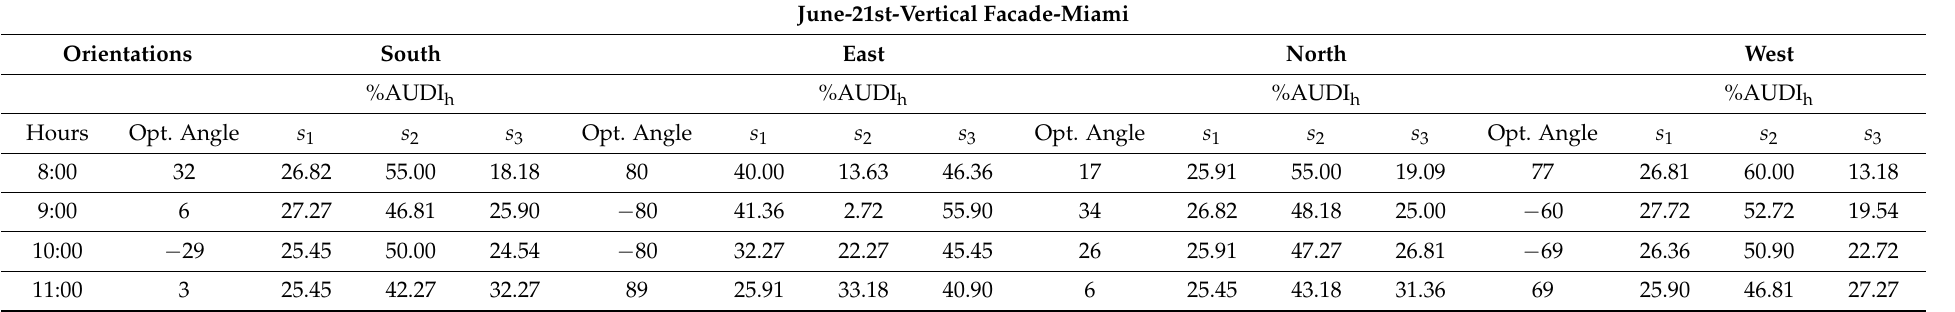
Table 7. The hourly optimum angles and their associated %sAUDI h on 21 June in Miami-Vertical louvers. June-21st-Vertical